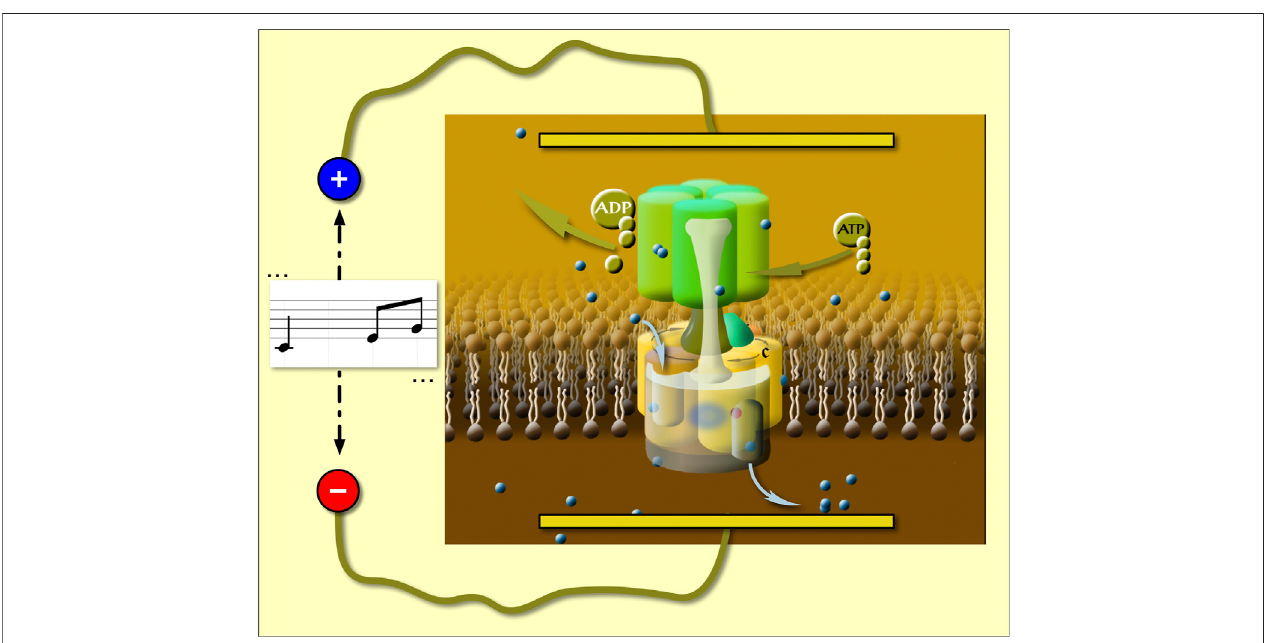
FIGURE 1 | The oscillating trans-membrane electric fi eld is parallel to the direction of the net vectorial proton transfer in V-ATPase [based on refs. (Ferencz et al., 2013; Ferencz et al., 2017)].